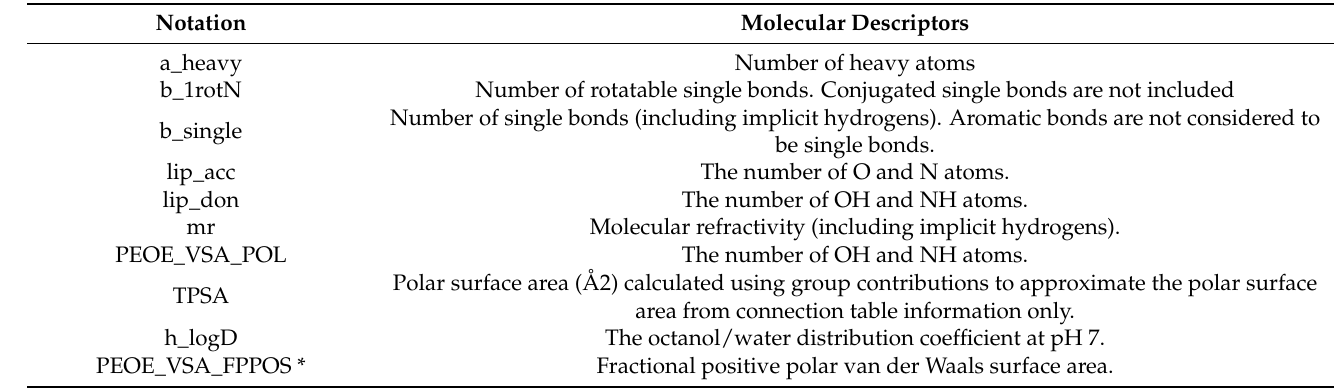
Table 4. List of selected 2D descriptors used to analyze the chemical space of molecules employed in this